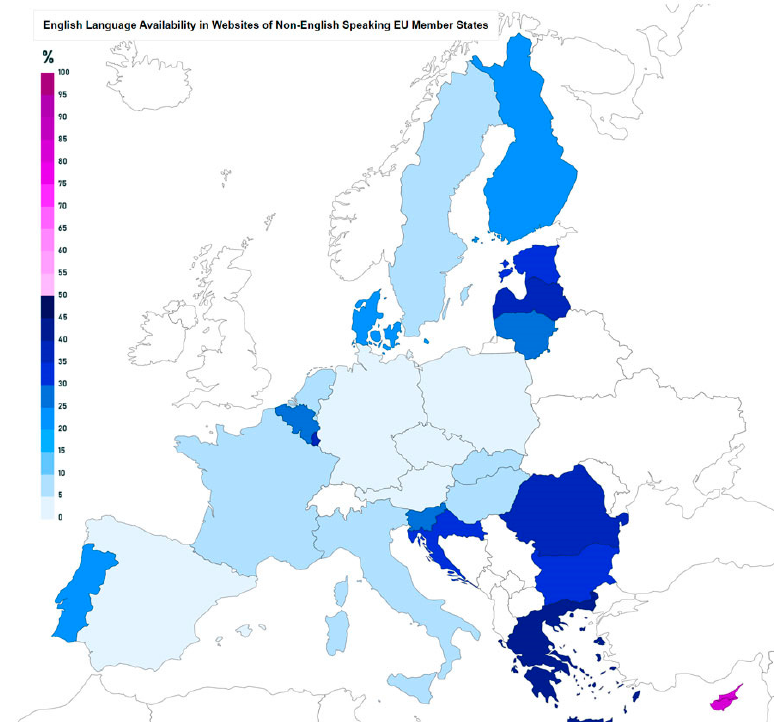
Figure 8. Map of English Language Availability in Websites of Non-English Speaking EU Member States.